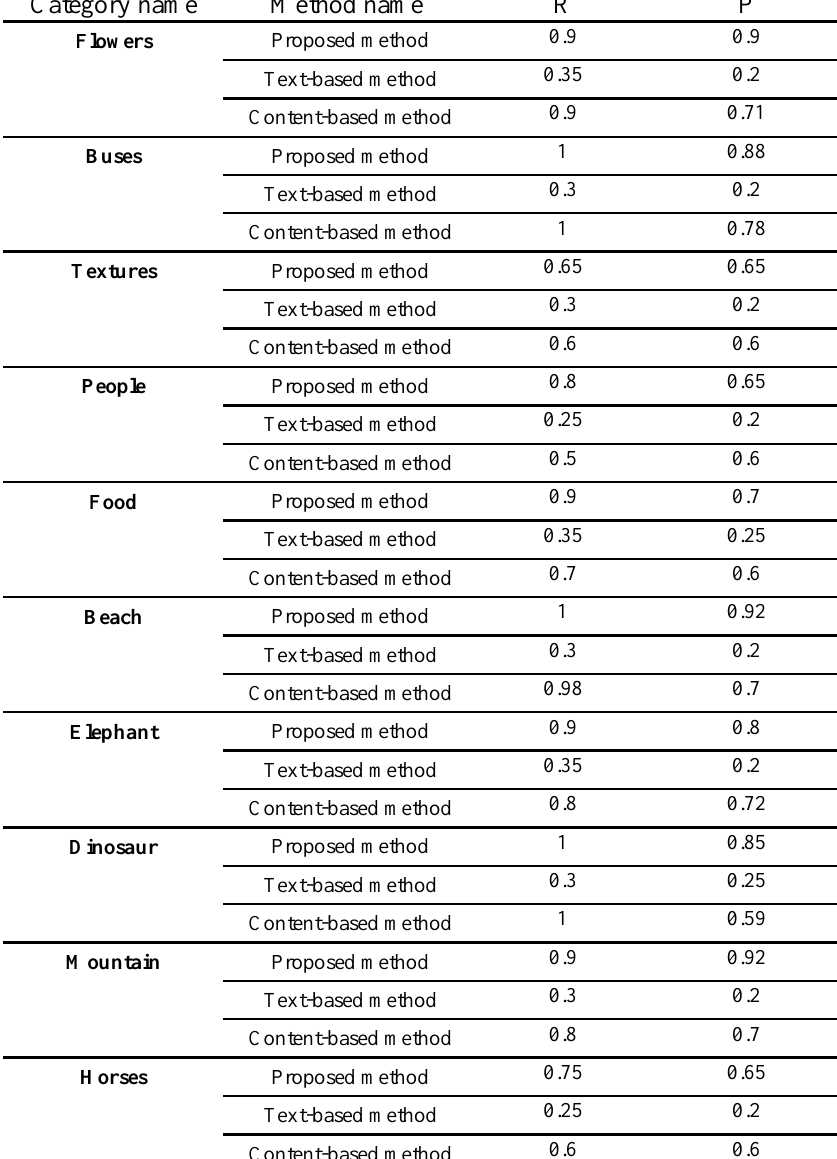
Table 2. Precision and Recall Comparisons between proposed Algorithm, Text-Based and content-based algorithms.